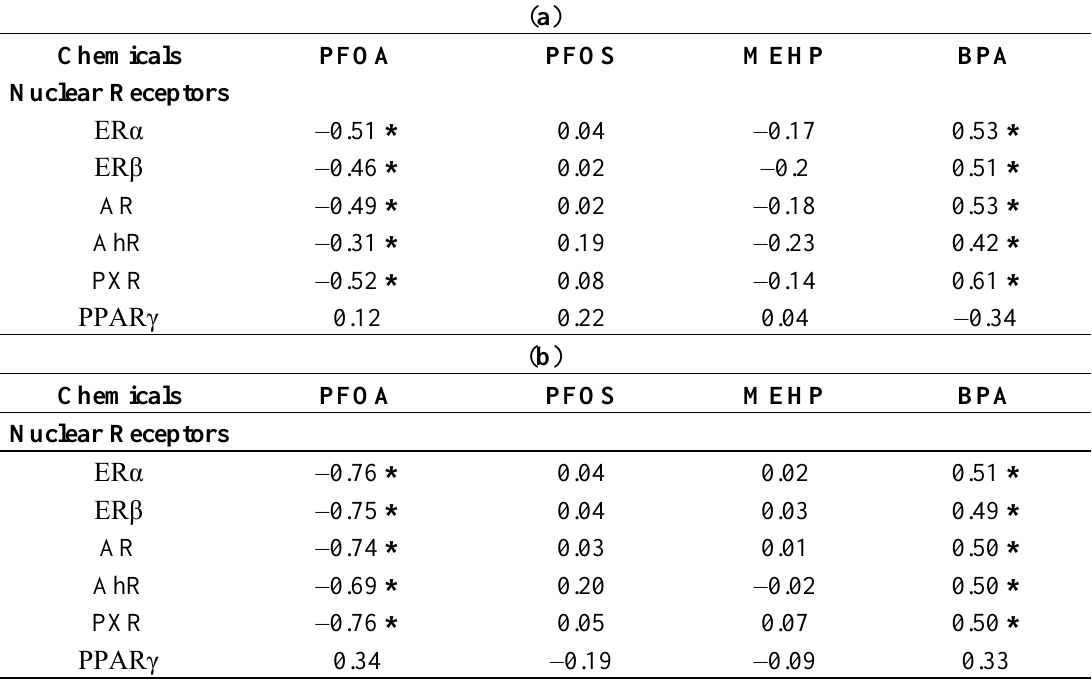
Table 6. Correlation between the endocrine disruptors concentration in blood/serum and nuclear receptors gene expression in infertile and fertile subjects (Spearman’s rank correlation test, Bonferroni corrected). ( a ) Fertile subjects; ( b ) Infertile